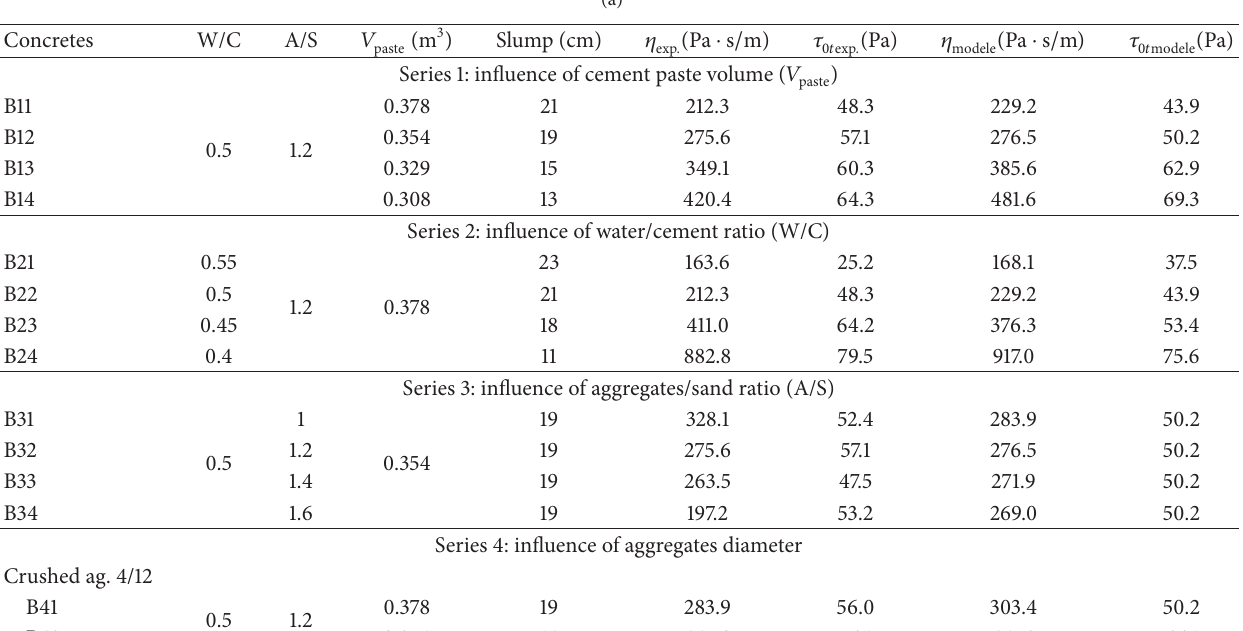
Table 3: (a) Comparison between the interface yield stress calculated by the model and that measured by the tribometer in the first test program. (b) Comparison between the interface yield stress calculated by the model and that measured by the tribometer in the second test